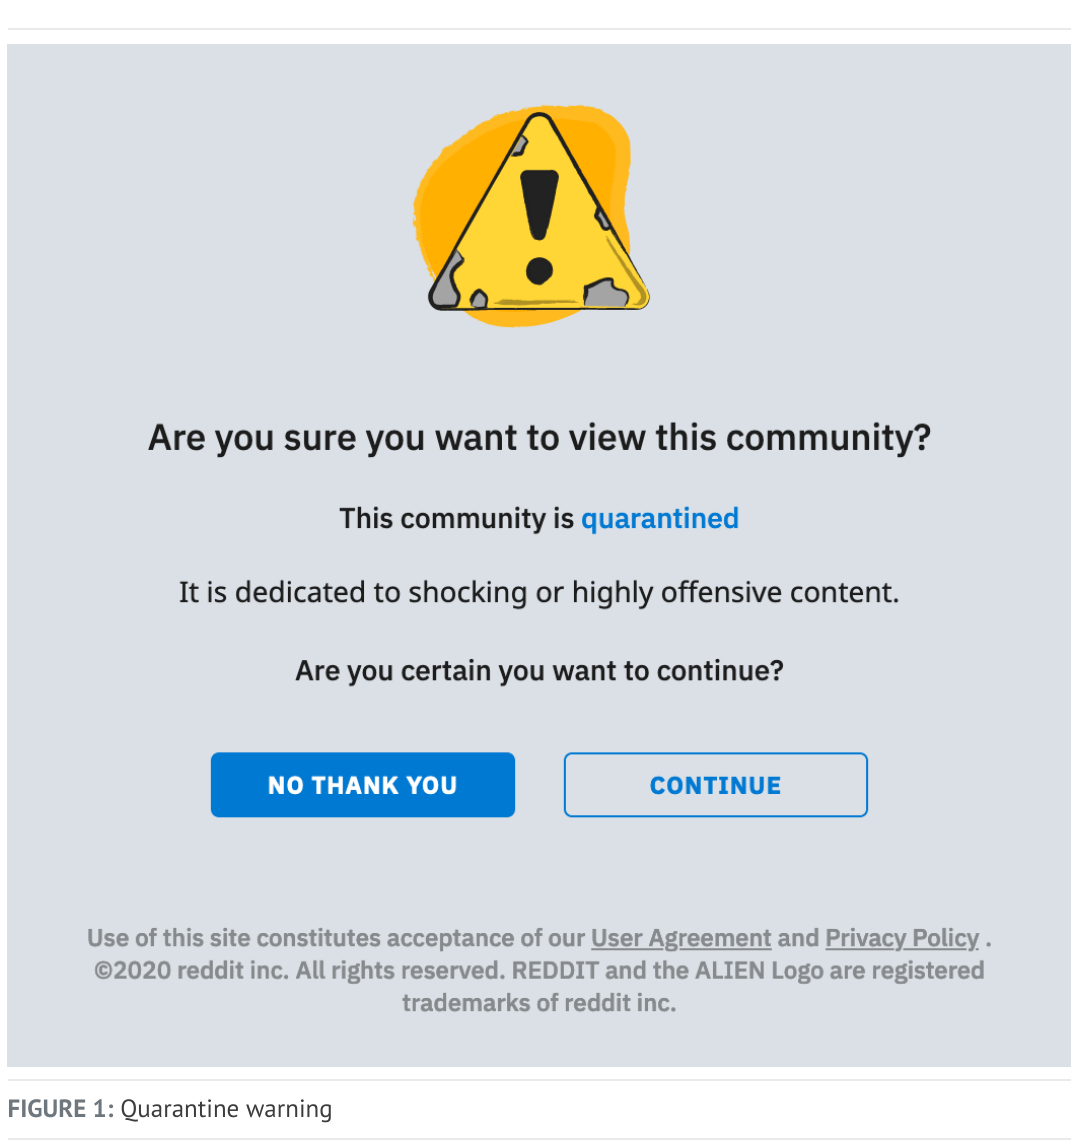
FIGURE 1: Quarantine